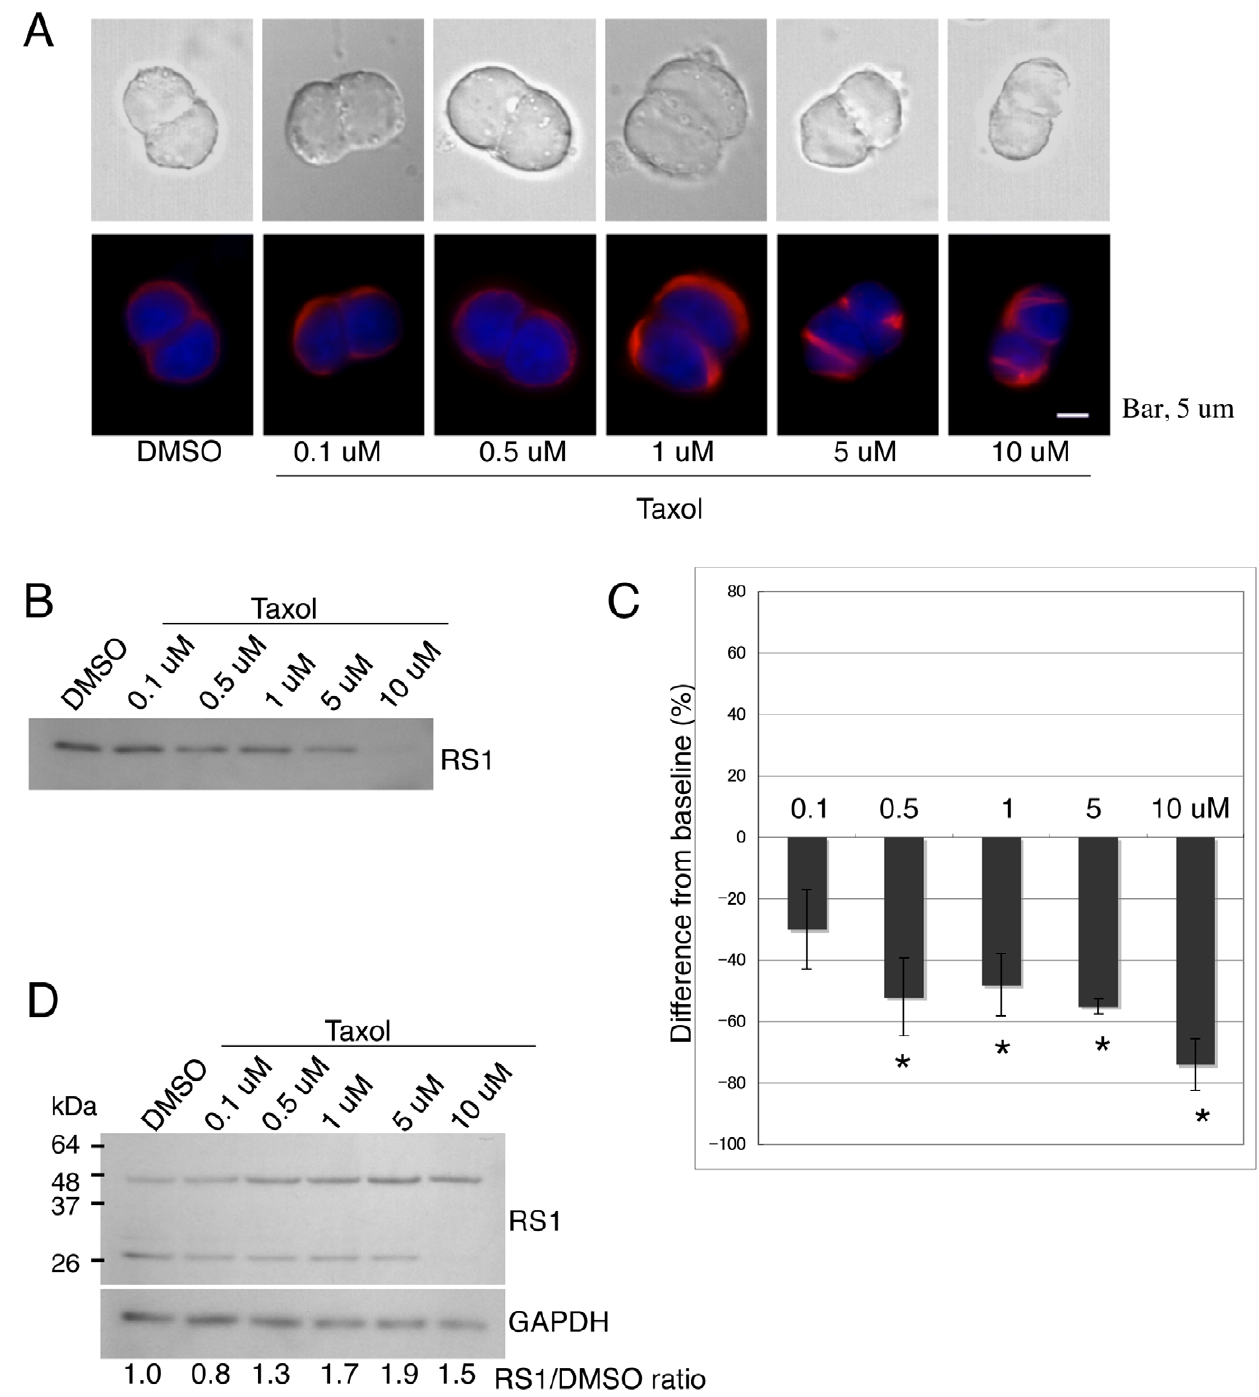
Figure 8. Retinoschisin secretion into the conditioned medium is decreased by addition of taxol. (A) Effects of taxol on cell morphology and microtubule organization. Weri-Rb1 cells were cultured with medium containing DMSO or the indicated concentrations of taxol for 72 h. Cells were then fixed and labeled with an a tubulin antibody (red). The upper and lower rows of pictures show transmitted light images and fluorescent light images, respectively. The microtubule cytoskeleton of cells shows bundles after treatment with 5 m M and 10 m M taxol. Bar, 5 m m. (B) Cells were treated with the indicated concentrations of taxol for 72 h and retinoschisin in the conditioned media was analyzed on Western blots using the RS24- 37 antibody. Retinoschisin secretion into the medium decreases in a dose-dependent manner between 0.5 m M and 10 m M taxol. (C) Quantification of the intensity of the bands from the Western blot in (B) (see MATERIALS AND METHODS). The data are means 6 SEM of three different biological samples for each condition. *: p , 0.05 was obtained for the differences between 0.5 m M–10 m M taxol-treated and DMSO-treated cells. (D) After 72 hr incubation in medium containing DMSO or the indicated concentrations of taxol, cells were collected and analyzed by Western blot using the RS24- 37 antibody. The intensities of the bands corresponding to the dimer and monomer of retinoschisin at each taxol concentration were added and normalized to GAPDH. The normalized values were compared to that of cells treated with DMSO and shown as RS1/DMSO ratios. Retinoschisin accumulates inside the cells exposed to taxol at concentrations between 0.5 m M and 10.0 m M. doi:10.1371/journal.pone.0020707.g008 PLoS ONE |